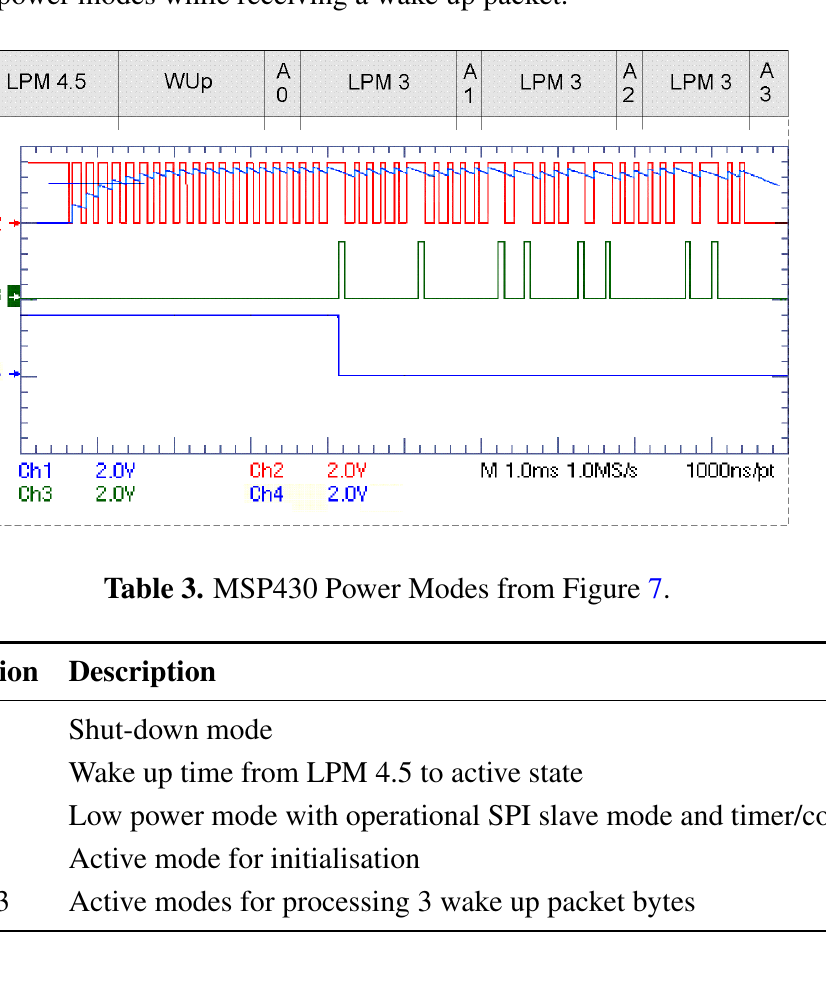
Figure 7. Measured wake up signal (1), SPI clock (2), SPI data (3), SPI enable (4) and MSP430F5x power modes while receiving a wake up packet.